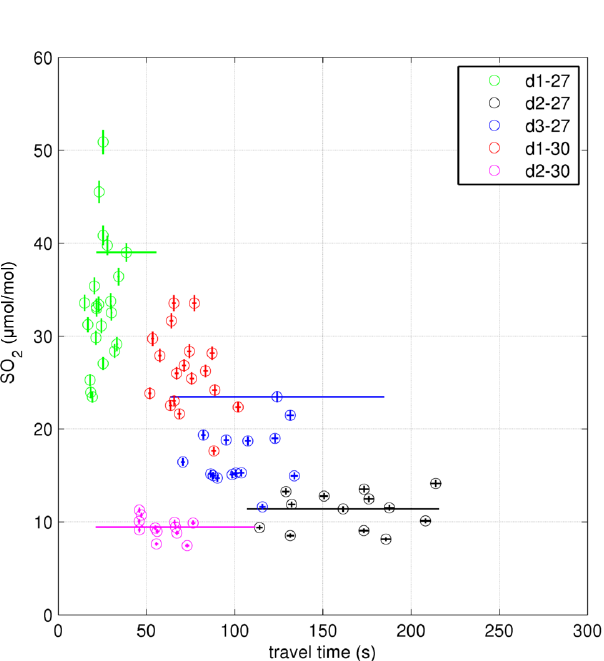
Figure 3. SO 2 mixing ratios against calculated processing time at the in-plume measurement sites. Error bars are 1 standard deviation, accounting for both variance in the values over the 120s of each bin and known errors of the